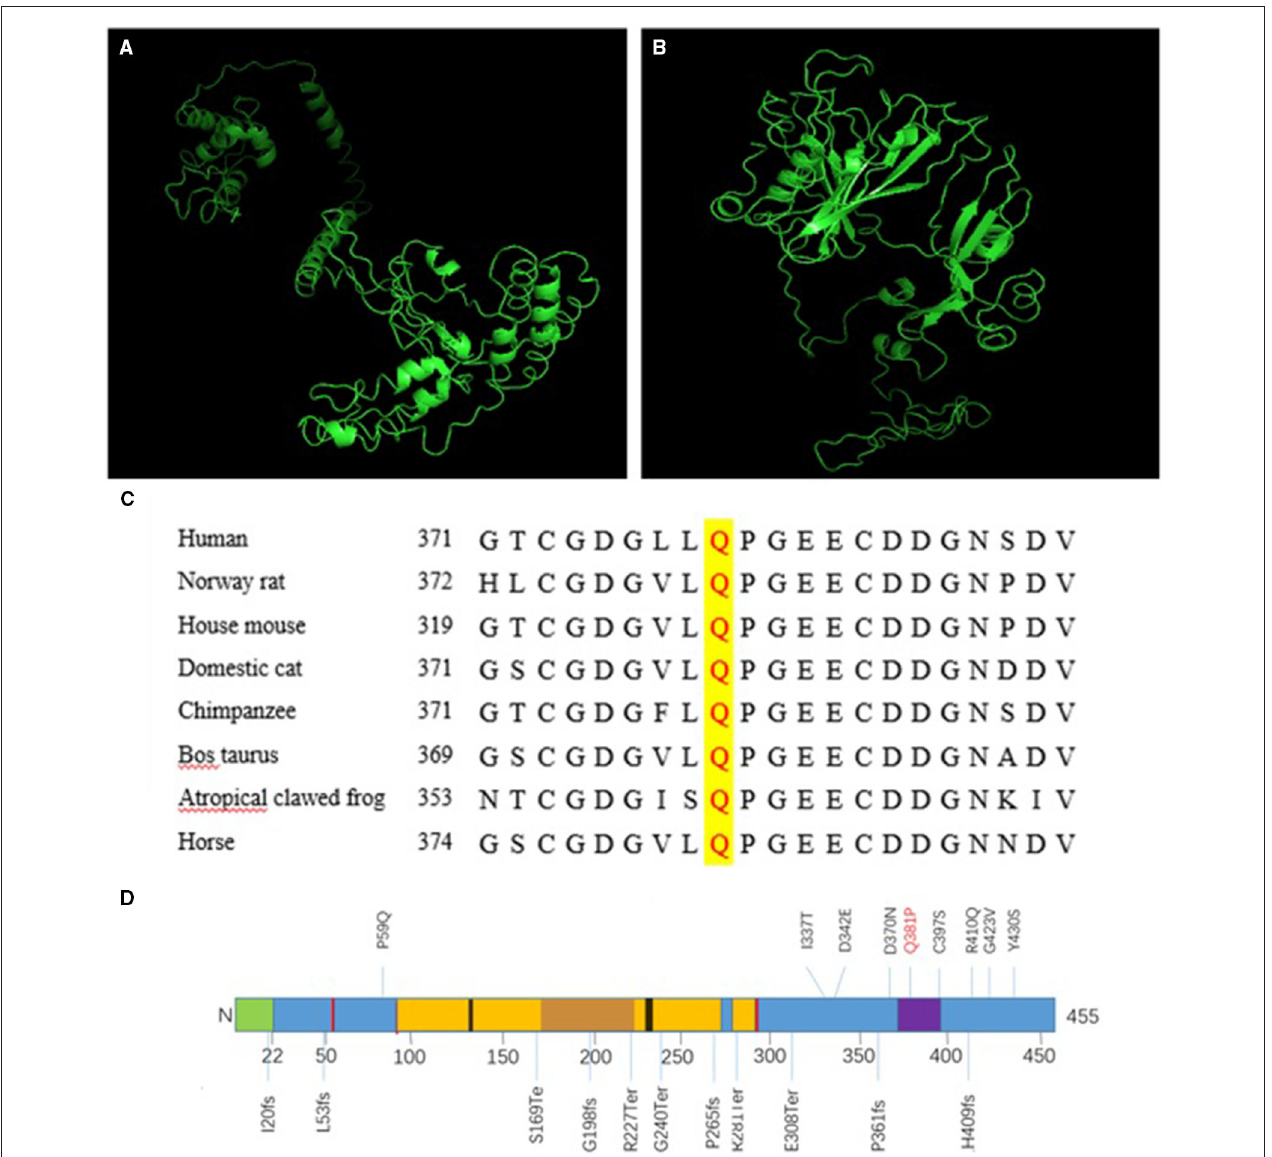
FIGURE 2 | A Three-dimensional structure of COLQ. (A) Wild-type protein, (B) missense mutant [c.1142A > C (p.Q381P)]. (C) Conservation studies were conducted for c.1142A > C (p.Q381P) in humans, Norway rats, house mice, domestic cats, cattle ( Bos taurus ), tropical clawed frogs, and horses. (D) Primary structure and common mutations in the COLQ protein. Signal peptide: 1–22 (green); disulfide bonds: 51, 52, 93, 291, 293 (red); heparan sulfate proteoglycan binding: 130–133, 235–238 (black); collagen-like 1: 96–269 (yellow); Myxococcus cysteine-rich repeat: 373–397